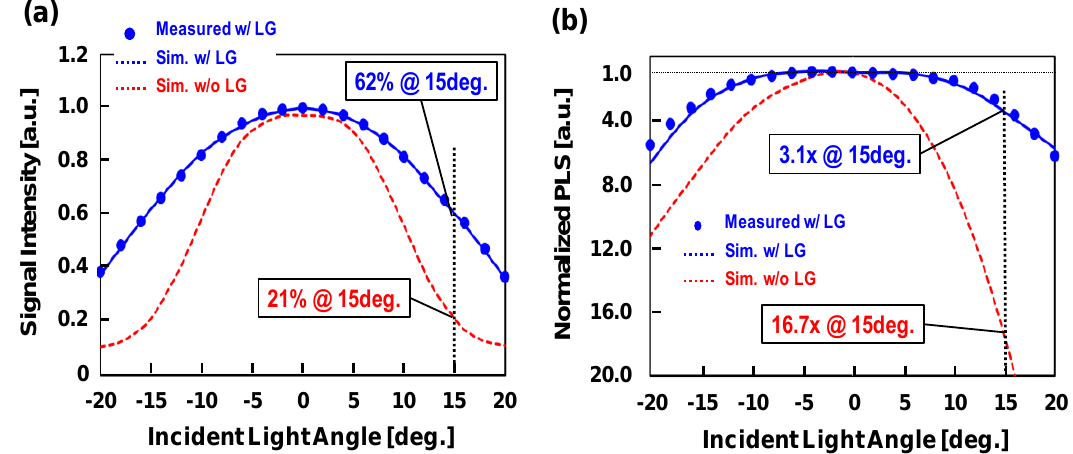
Figure 13. Measured and simulation results of the incident light angle dependence of ( a ) sensitivity and ( b ) PLS.